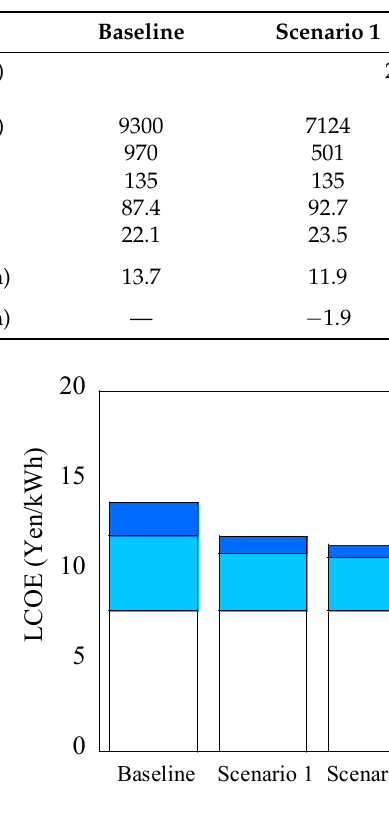
Table 8. Cost-reduction scenarios in Japan. Table 8. Predicted LCOE for each scenario in Japan.